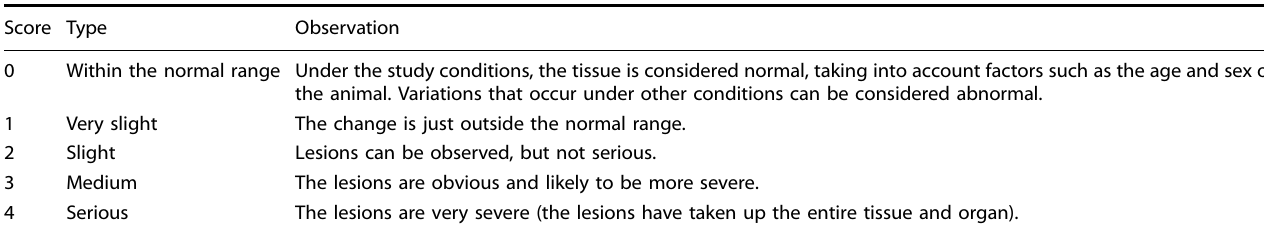
Table 1. Lung histopathology scoring